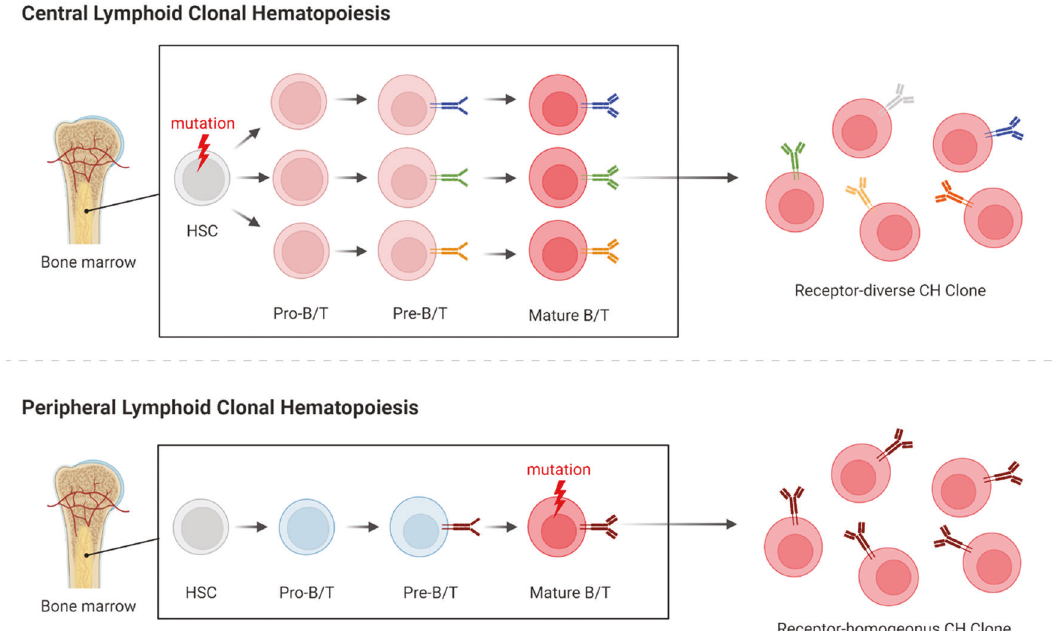
Fig. 2 Lymphocyte Receptor Diversity in Clonal Hematopoiesis. During lymphocyte development, HSC ’ s follow a multi-step differentiation pathway which includes the rearrangement of BCR or TCR genes for B cells and T cells respectively. Receptor rearrangement de fi nes distinct stages of lymphocyte development with the rearrangement of the immunoglobulin heavy chain or TCR β de fi ning the transition from pro-B/T to pre-B/T cells and the subsequent rearrangement of the immunoglobulin light chain or TCR α chain occurring during the transition from pre- B/T to mature B/T cells. Stochastic rearrangement of lymphocyte receptor genes in each developing cell produces a diverse repertoire of B and T cells. ( Upper ) CH mutations which occur in the HSC, de fi ned here as central lymphoid clonal hematopoiesis, are carried forth in all progeny cells which then undergo receptor rearrangement to form a receptor-diverse CH clone. ( Lower ) CH mutations occurring in mature lymphocytes which have already completed receptor rearrangement, de fi ned here as peripheral lymphoid clonal hematopoiesis, will expand and form a receptor-homogenous CH